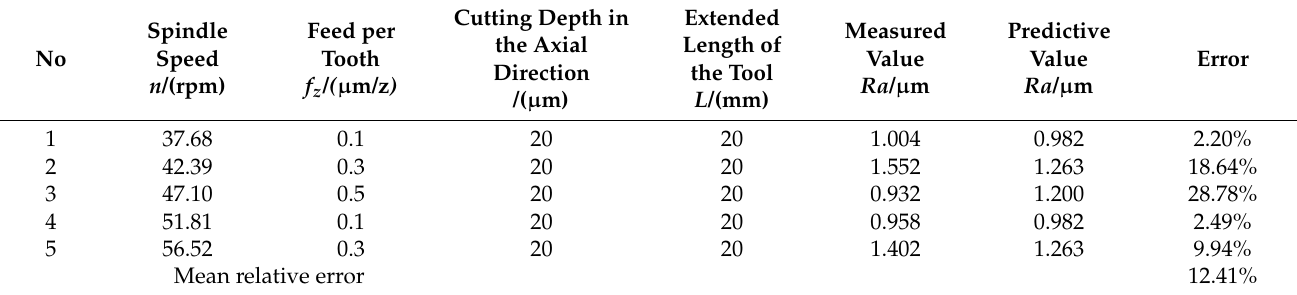
Table 5. Predicted and measured surface